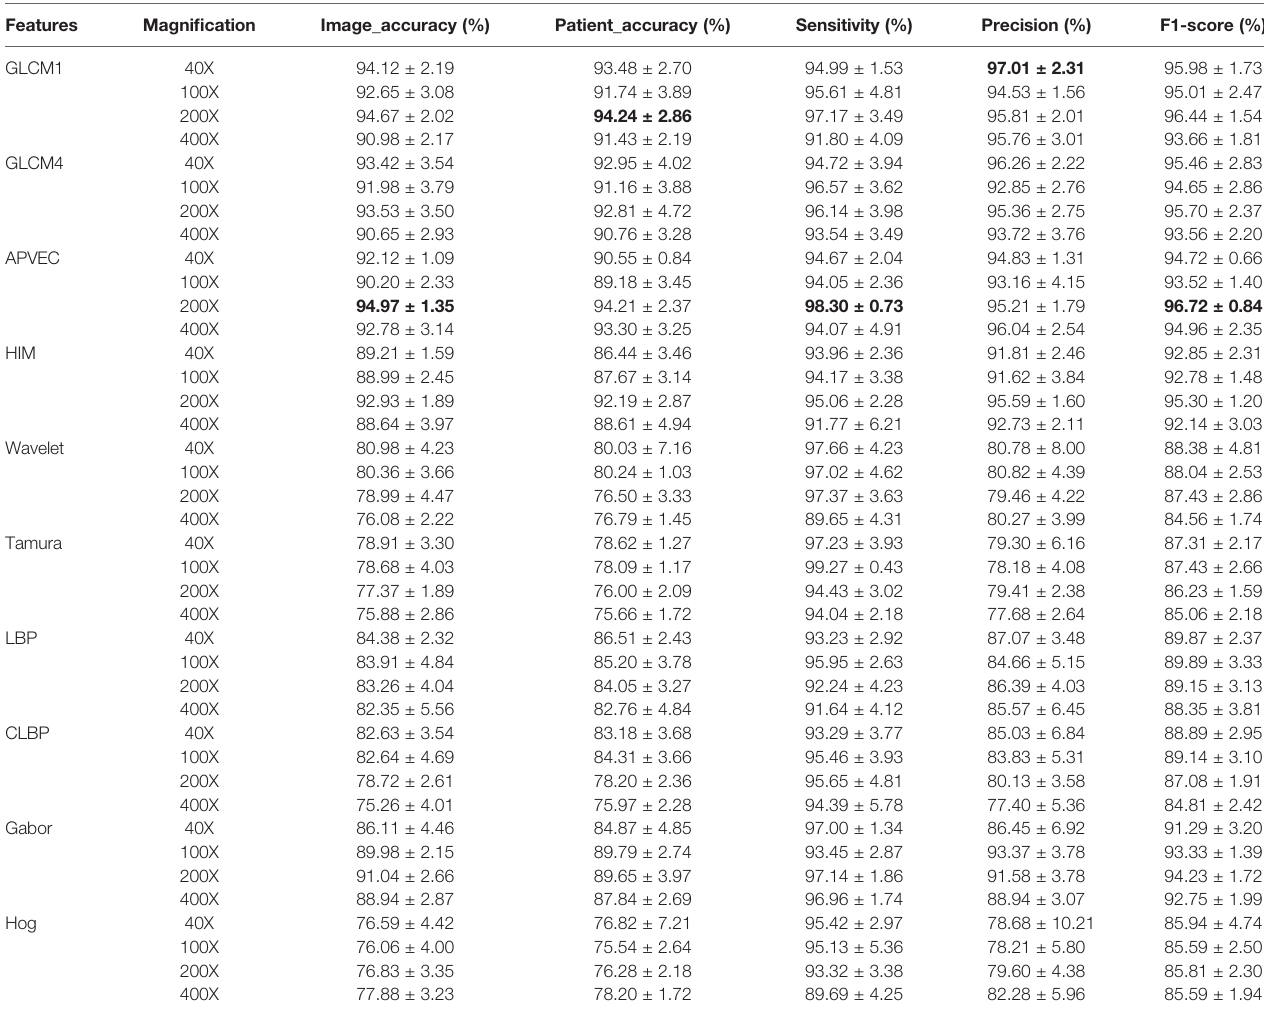
The bold values indicate the best value of each